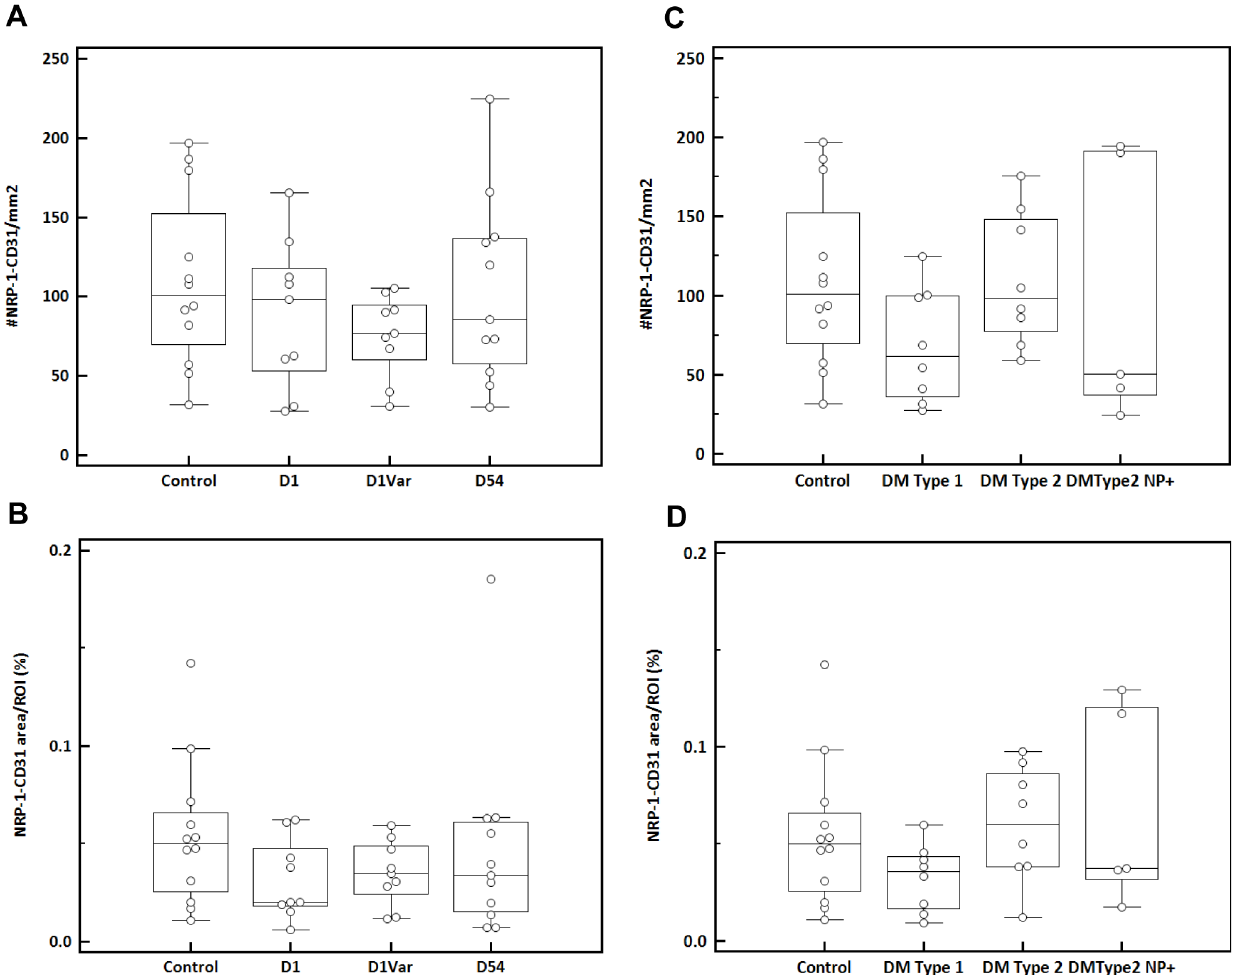
Fig 7. Definiens analysis of vascular NRP-1 receptor expression in dermis. (A) Number of NRP-1/CD31 positive structures (#/mm 2 ) and (B) NRP-1/CD31 positive area/ROI (%) in dermis of controls, healthy volunteers who received topical capsaicin at day 1 (D1), a variable time point (Dvar) and day 54 (D54) after capsaicin was applied. (C) Number of NRP-1/CD31 positive structures (#/mm 2 ) and (D) NRP-1/CD31 positive area/ROI (%) in dermis of controls, diabetic subjects Type 1 (DM Type 1), Type 2 (DM Type 2) and diabetic subjects suffering from polyneuropathy (DM Type 2